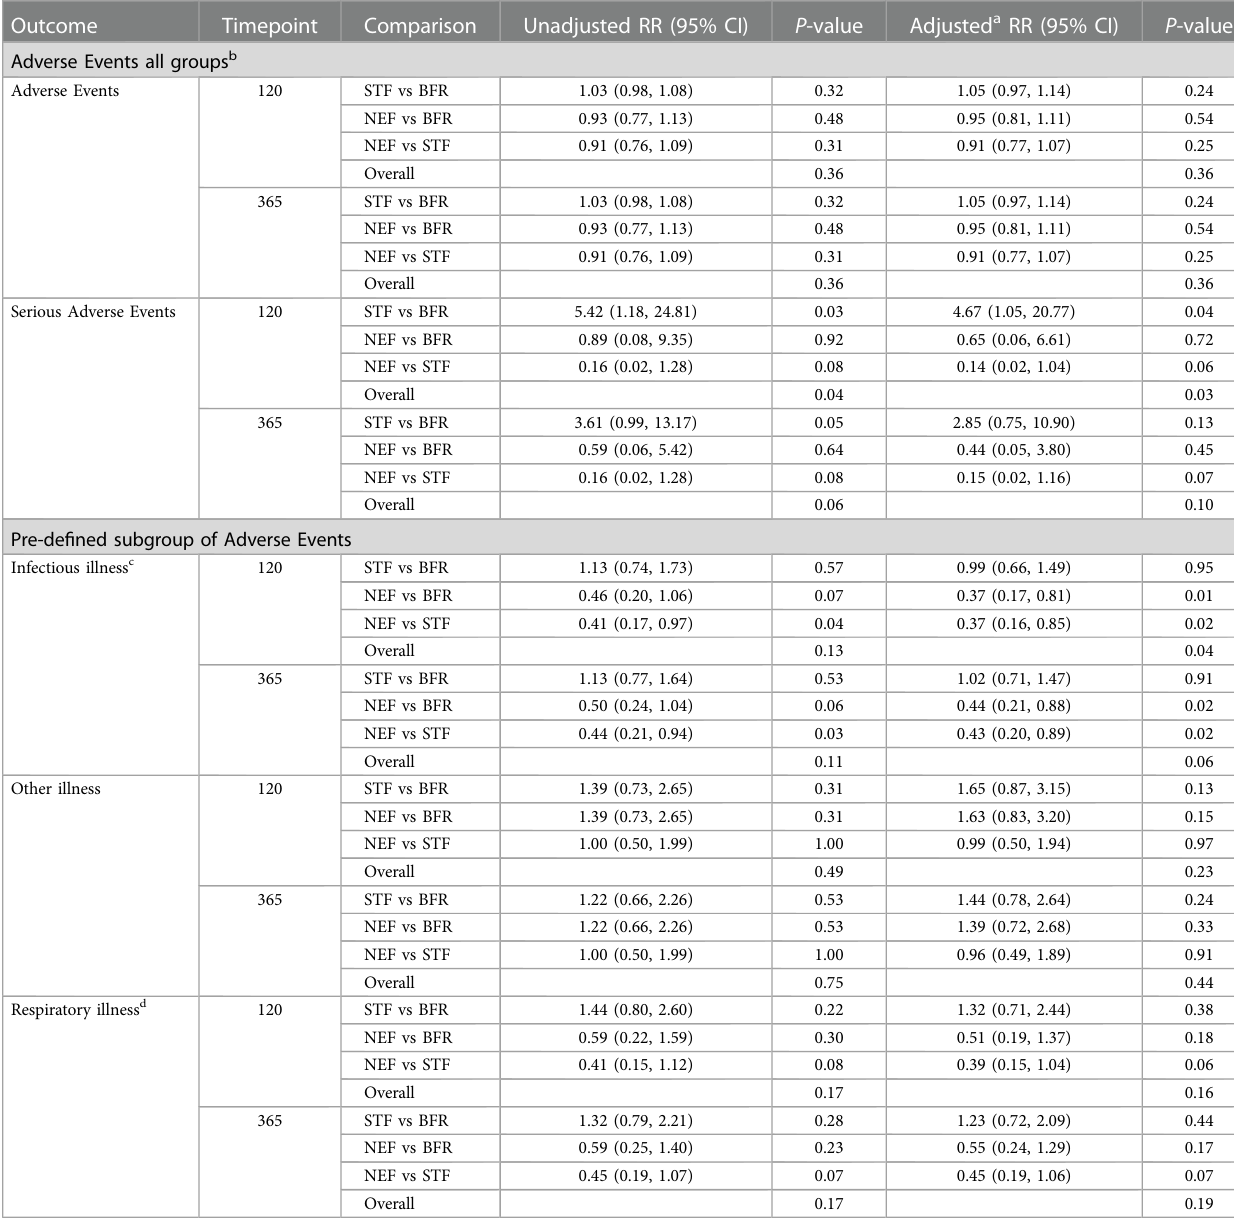
TABLE 8 Adverse